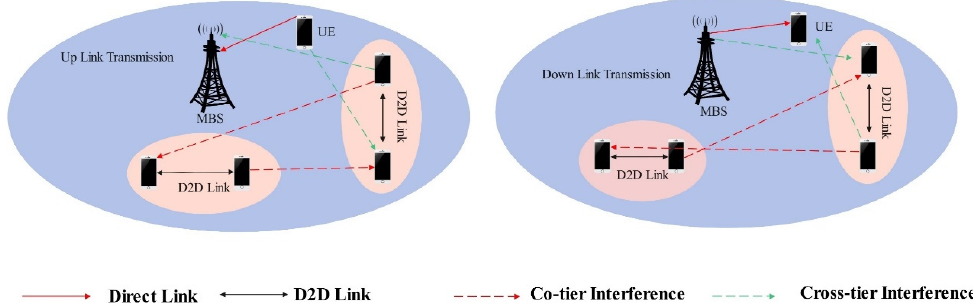
Figure 9. The interference in D2D HetNet.